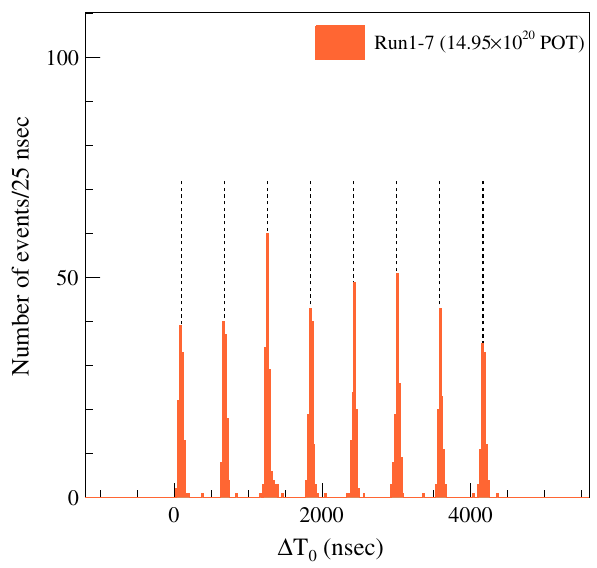
Fig. 66 Δ T 0 distribution zooming in around 0 showing the accelerator bunch structure [62]